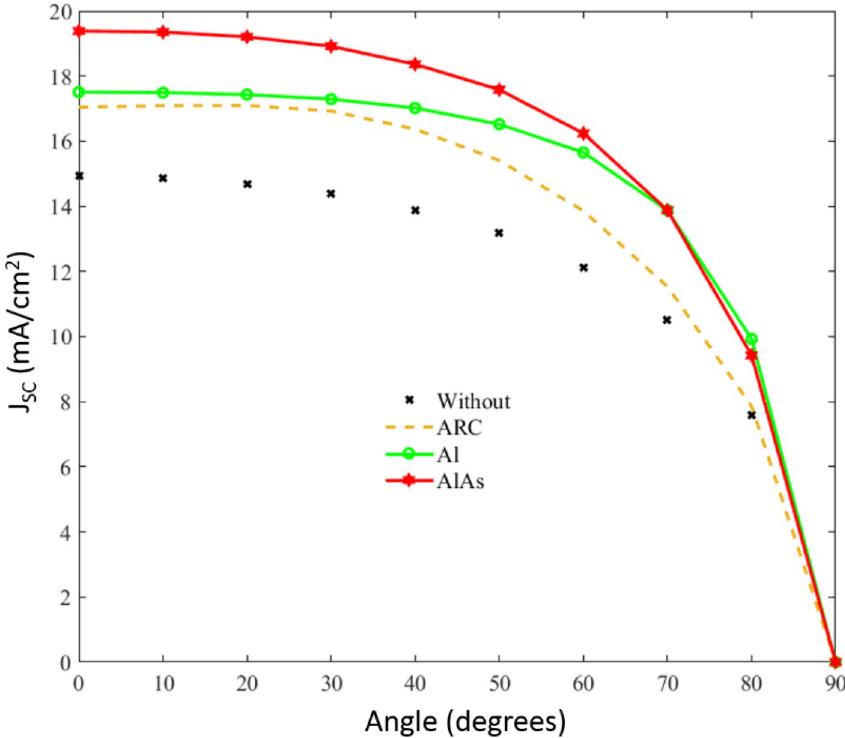
Figure 5. Short-circuit current density (J SC ) as a function of the incident angle for the considered cases of a standard GaAs solar cell (x—none line), a GaAs with an ARC (dashed line) and a GaAs with nanoparticles on it. These nanoparticles are either metallic ones (o—solid line) like in ref 31 or the proposed dielectric AlAs nanoparticles (hexagram—solid